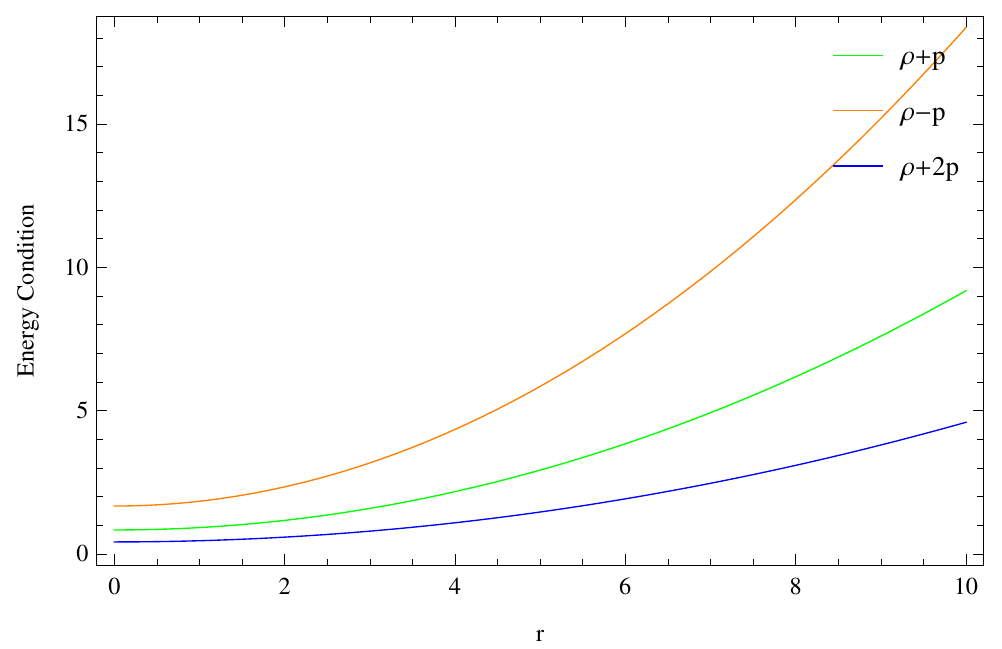
Figure 20. The energy conditions for quintessence field are shown against the radial parameter r with the values of the arbitrary constants C 3 = 2, C 4 = 0.001, C 5 =